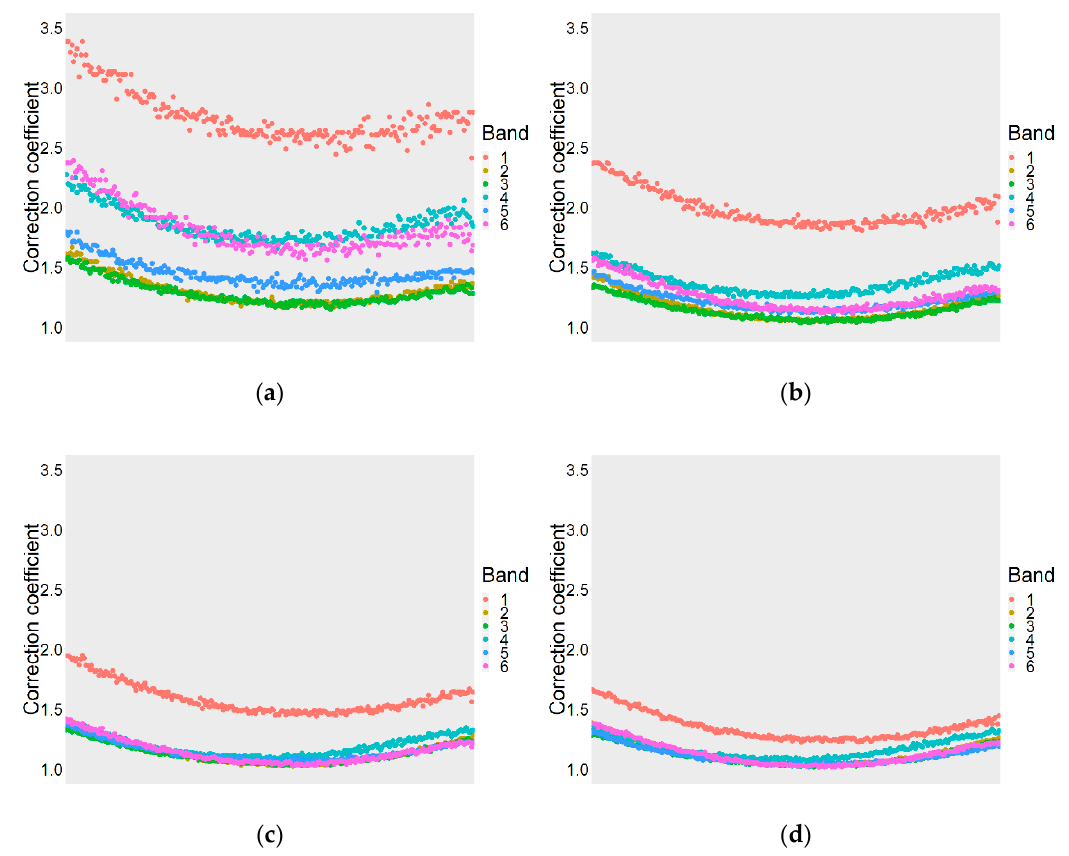
Figure 15. The vignetting radial falloff of each band at the 40% of the integrating sphere source maximum intensity: ( a ) Exposure time 50 μ S; ( b ) Exposure time 250 μ S; ( c ) Exposure time 500 μ S; ( d ) Exposure time 1000 μ S.